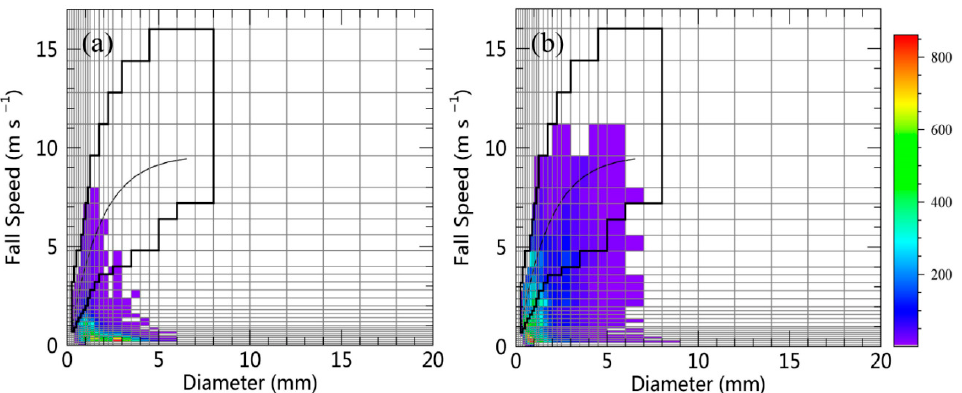
Figure 2. Identification and elimination of ( a ) snow sample case and ( b ) mix-phase sample case in total winter rainfall observations. The black curve represents the empirical fitting result of raindrops as reported by Friedrich et al. [35]. The black box represents rainfall area. The color mark represents particle number.